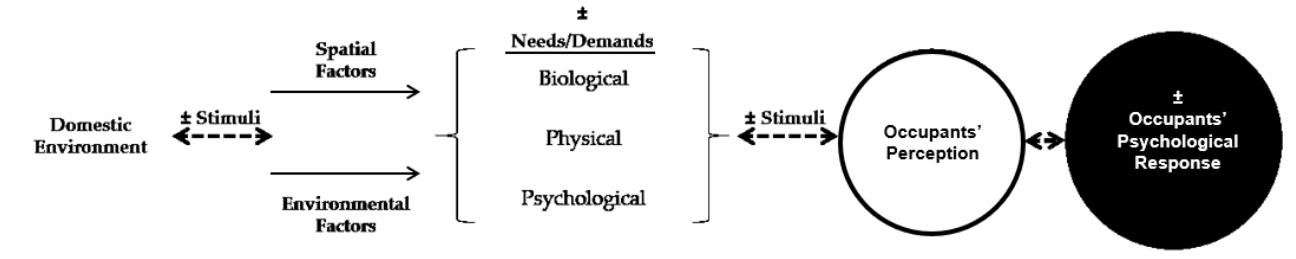
Figure 6. Occupants ’ perception of the domestic environment (source: author). Figure 6. Occupants’ perception of the domestic environment (source: